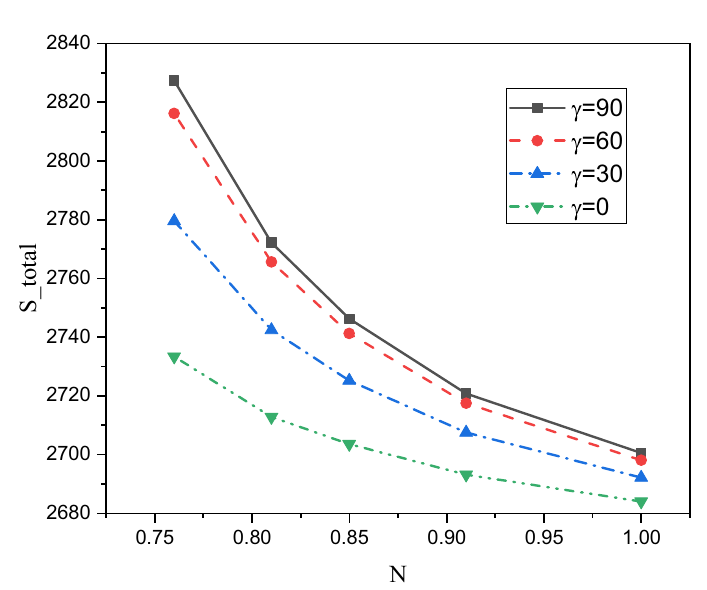
Figure 7. Impacts of the power-law index N and inclination angle γ on the total entropy generation at Ra = 10 5 , Da = 10 − 3 , b = 0.6, d = 0.5, Ma = 1000, β = 0.95, τ = 1, φ = 2%, Rd = 1, � = 10 − 4